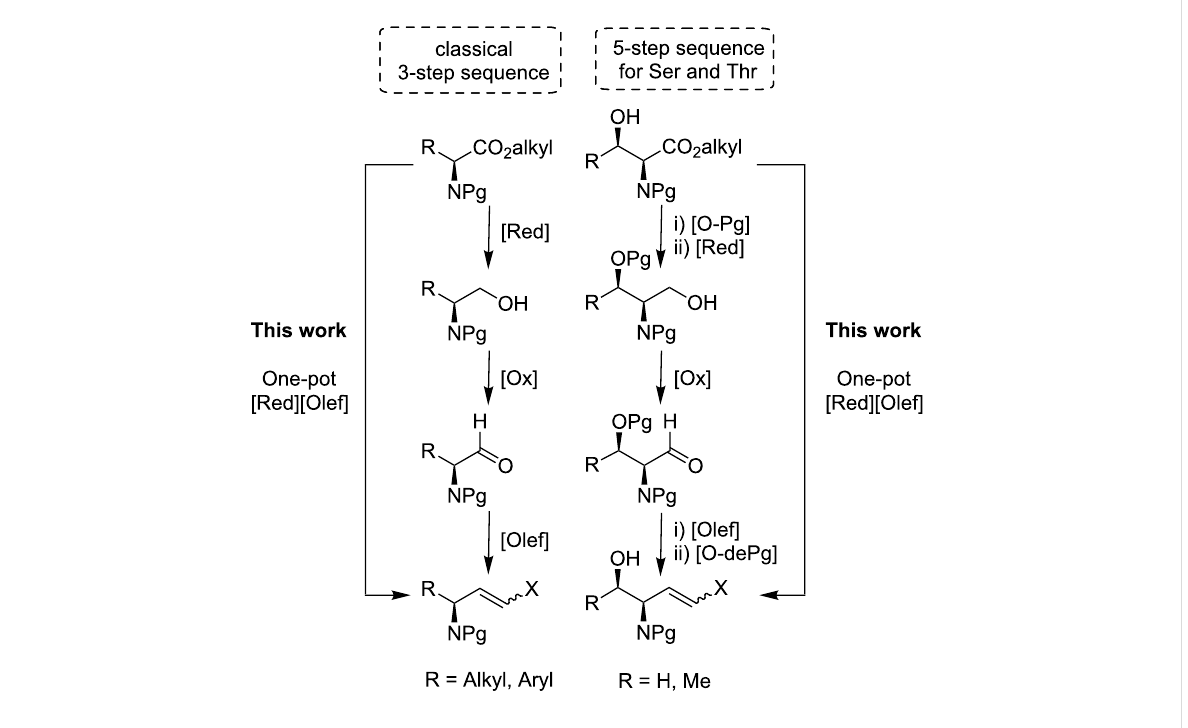
Figure 1: Strategies for the synthesis of N -protected allylic amines. [Red], reduction; [Ox], oxidation; [Olef], olefination; [Pg], protecting group.